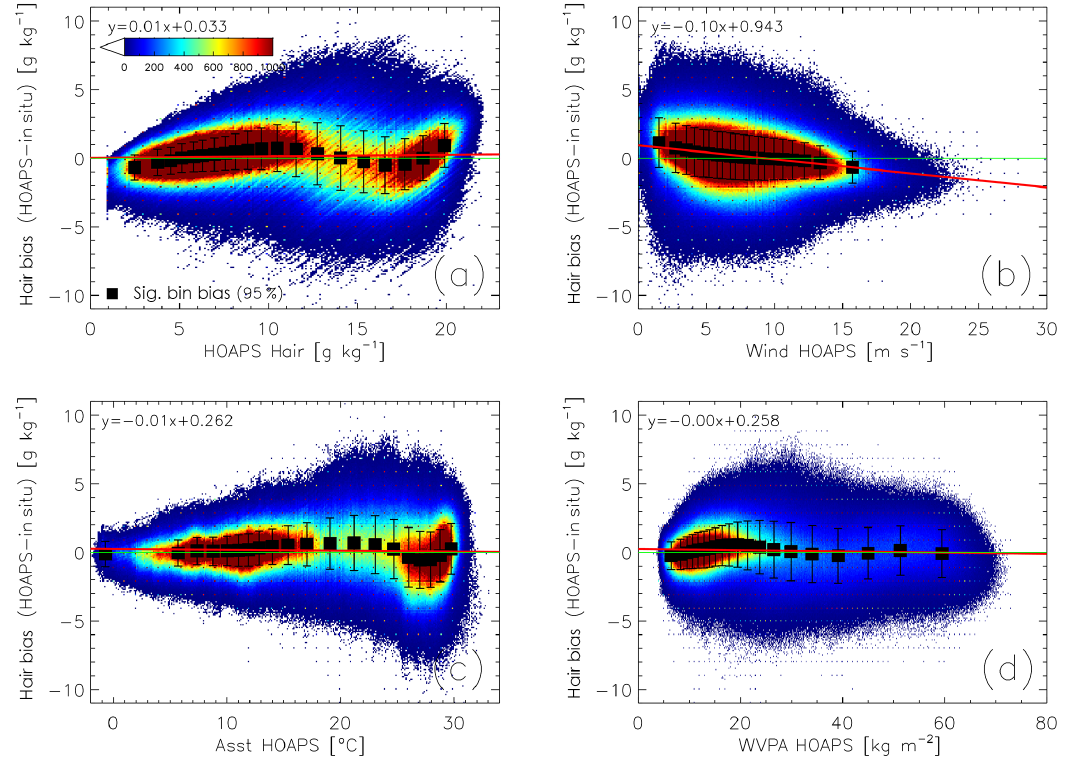
Figure 2. Scatter density plots of q a bias (HOAPS 3.3 minus in situ, gkg − 1 ) as a function of (a) q a (“Hair”), (b) U (“Wind”), (c) SST (“Asst”), and (d) vertically integrated water vapour (“WVPA”), based on global double collocations between 2001 and 2008. The black squares and error bars represent bin-averaged systematic uncertainties (significant at the 95% level) and their SDs, whereby each bin contains 5% of all double collocated matchups. Note that the bars include random uncertainty contributions from the satellite retrieval, the collocation procedure, and the in situ measurement uncertainty. Panel (a) is a revised version of Fig. 3 published in Kinzel et al.